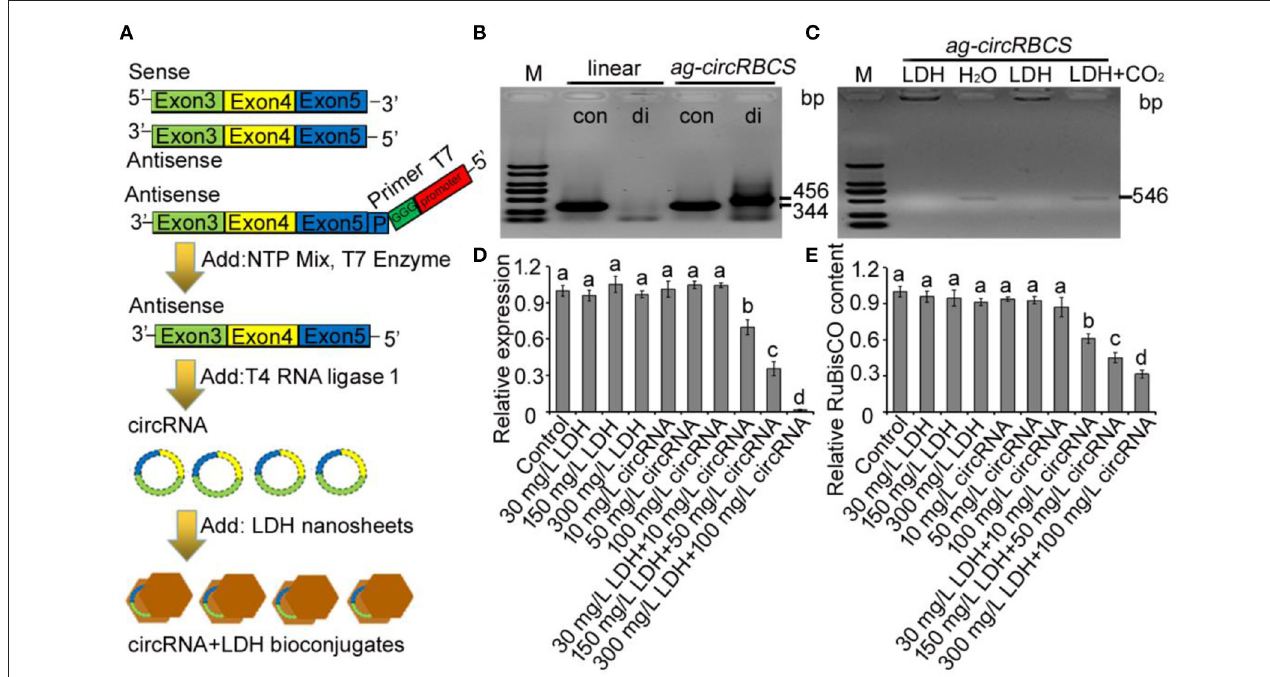
FIGURE 3 | ag-circRBCS regulates RBCS gene expression. (A) Flowchart for artificial synthesis of ag-circRBCS and transported via layered double hydroxide lactate nanosheets (LDH-lactate-NS) in vitro . (B) The identification of synthesis ag-circRBCS via PCR. The convergent (con) and divergent (di) primers were used for analysis. (C) Analysis of the adsorption efficiency of LDH-lactate-NS in vitro . (D) Relative expression level of RBCS genes under different treatments. Numbers in (B,C) indicate the expected RNA length. (E) Analysis of the RBCS protein content via ELISA. M, marker; linear, synthesized single strand RNA before circulation; LDH, layered double hydroxide lactate nanosheets. Actin was used as an internal control. Data are expressed as mean ± standard deviation from three independent experiments. All the data were analyzed for significant differences using ANOVA with Duncan’s test. Different lowercase letters represent statistical significance of p < 0.05 ( n = 3).